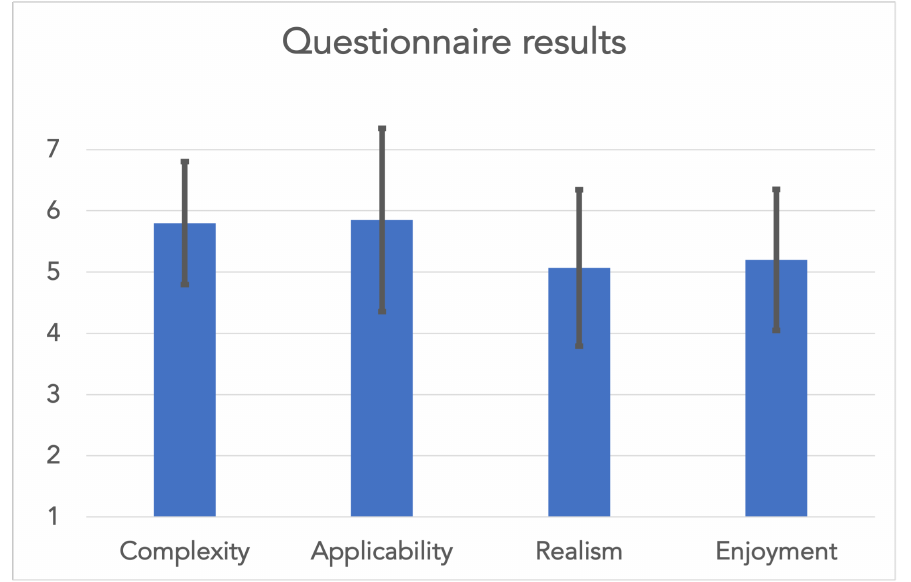
Figure 3. Average ± standard deviation of the questions asked to five users during a preliminary study to rate the complexity (1 difficult, 7 easy), applicability (1 impractical, 7 practical), realism (1 not realistic, 7 very realistic), and enjoyment (1 boring, 7 entertaining) of the